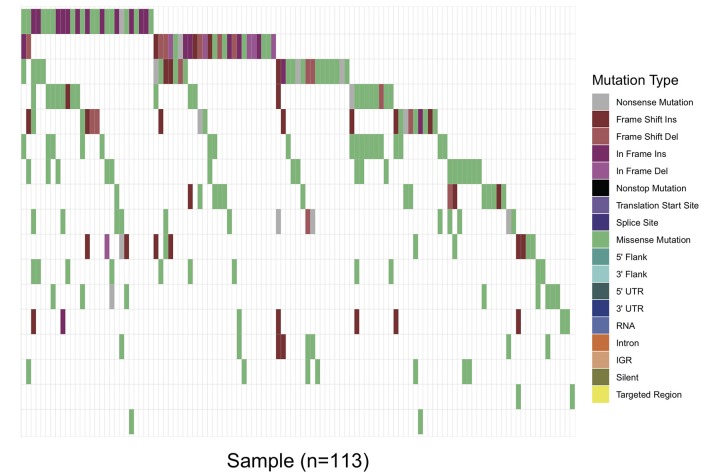
Waterfall plot of the detailed gene mutation spectrum of 113 AML patients. Each variant subtype is labeled with a unique color. The upper panel demonstrates the mutational burden per megabase DNA (MB) for each patient.